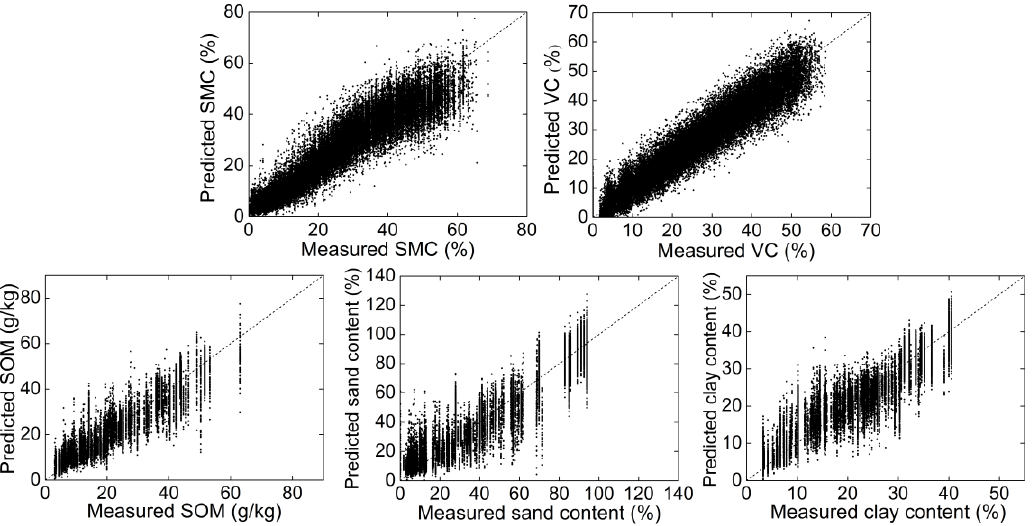
Figure 5. Predicted and measured soil properties and vegetation coverage (VC) values of 20 ran- domly selected test sets of the one-dimensional convolutional neural network (1DCNN) model. The black dash line is the 1:1